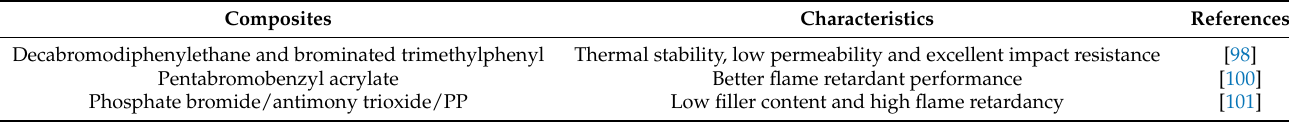
Table 1. Halogen flame retardants and their